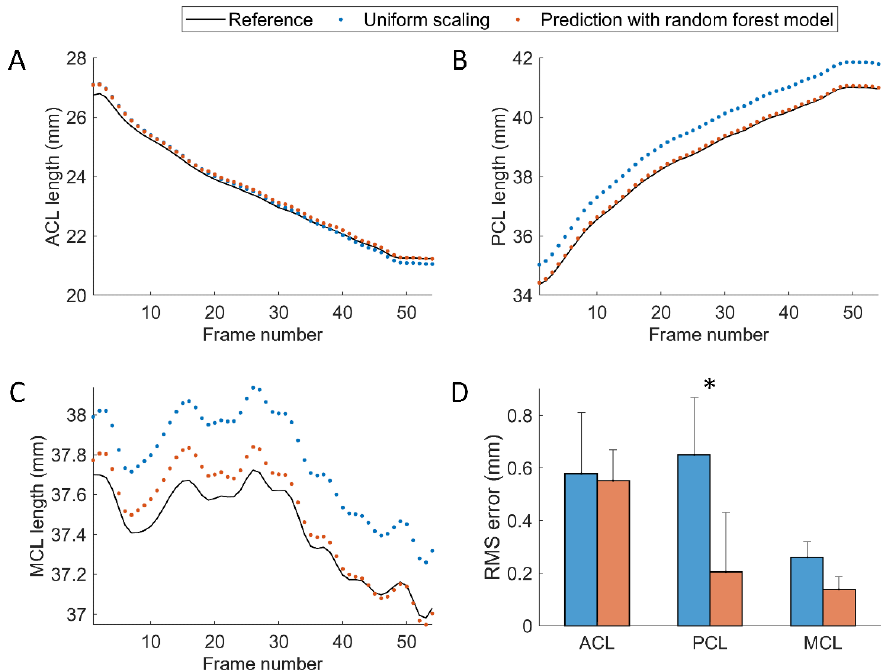
Figure 5. The length variation of the ( A ) ACL, ( B ) PCL, and ( C ) MCL obtained using the biplane MBT-determined bone poses (black solid lines) and predicted via uniform scaling factor (blue dots) and the random forest model (orange dots). The data were obtained from a typical subject performing lunge activity. ( D ) The root-mean-squared (RMS) errors of the predicted ligament lengths obtained using uniform scaling factors and the random forest models. The asterisk indicates the significant differences in RMS error between the two methods.